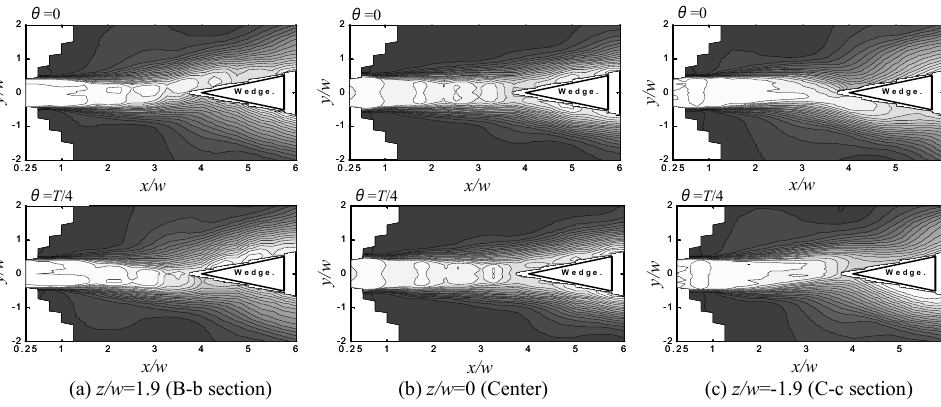
/))(~ ( UuU θ+ with control of pattern 3. Contour spacing are 5.0 × 10 -2 Fig.8 Contour maps of 0